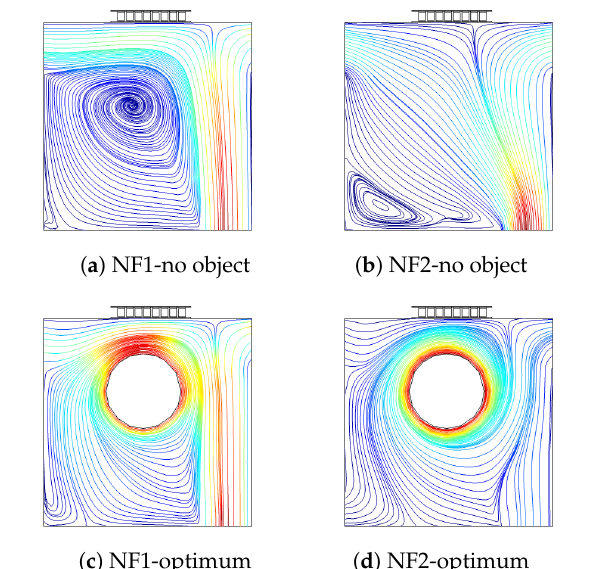
Figure 11. FP variations in the 2D mid-plane of the VC for the case of no-object ( a , b ) and the optimum conditions ( c , d ) using NF1 and NF2.